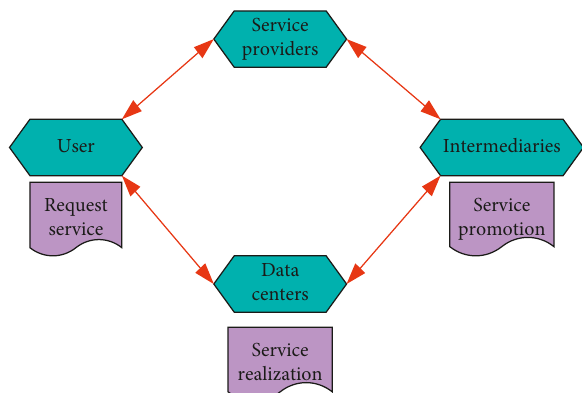
Figure 4: Schematic diagram of service mode based on the data